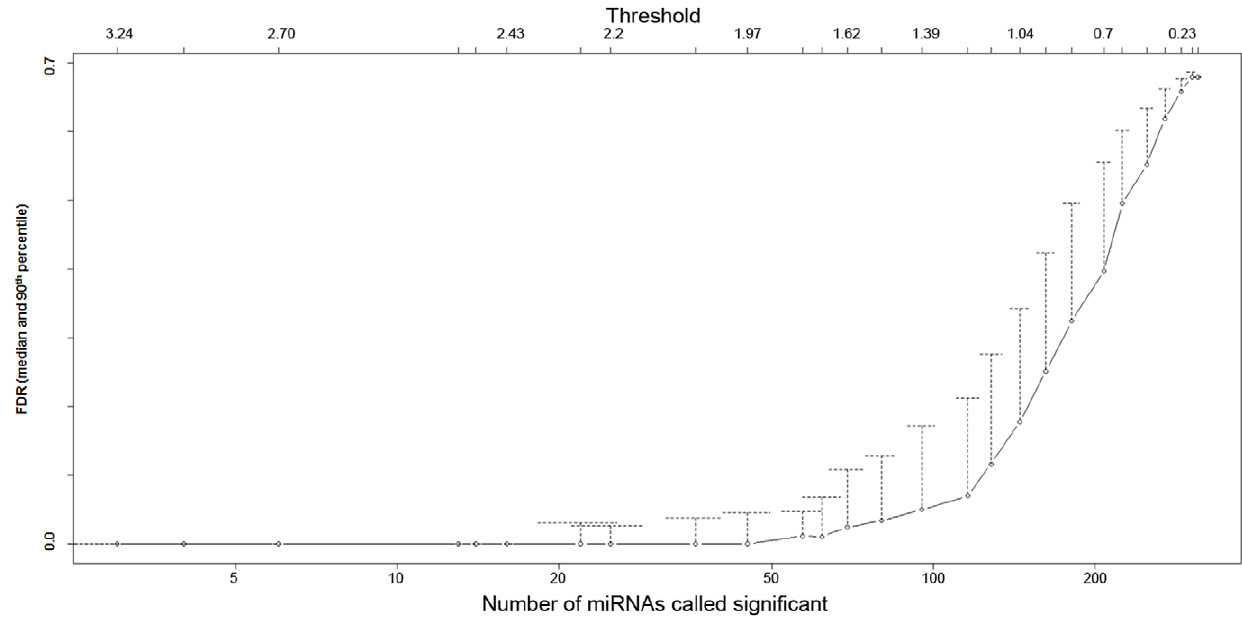
Figure 2. Median and 90th percentile of False Discovery Rates (FDR) in order left-to-right of threshold value and number of statistically significant results for all three groups (C, BD, and SZ). The Y-axis is an estimate of the percentage of false positives. High-ranked miRNA (at the left) have a low rate of false positives, while lower-ranked miRNA (moving toward the right) have higher rates of false positives.